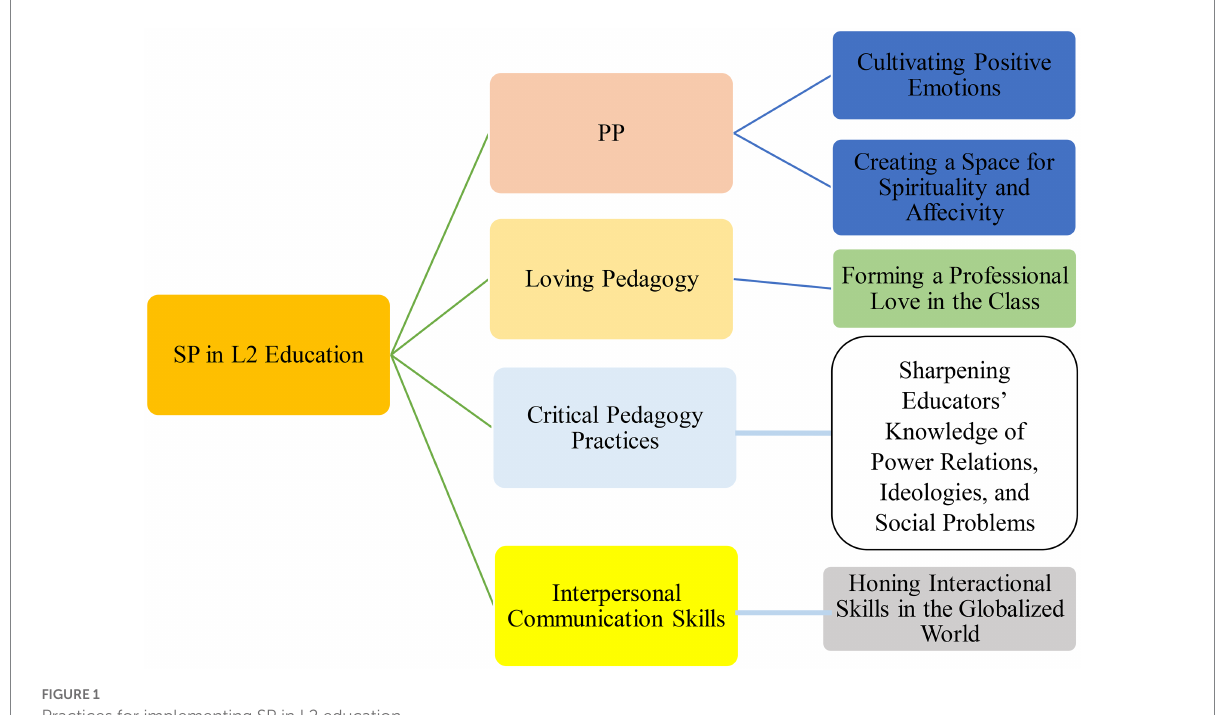
FIGURE 1 Practices for implementing SP in L2